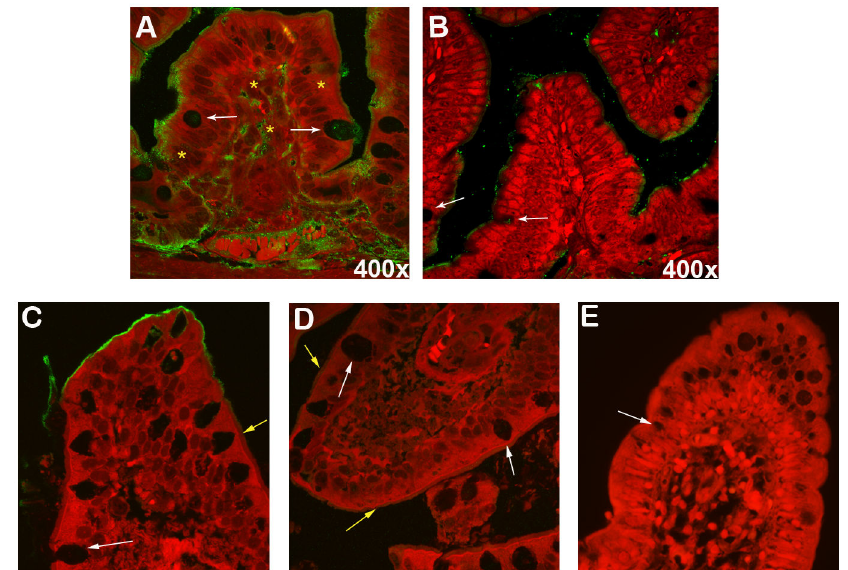
Figure 6. Ricin binds to villi in the small intestine. IF of small intestines from mice 24 hours after gavage with ricin (A) or PBS (B). Ricin was detected by IF after treatment with primary rabbit polyclonal anti-RTA and goat anti-rabbit Ig-AlexaFluor ® 488 secondary antibody. Note that the small intestines from 3/3 mice euthanized at 24 hours post gavage were positive for ricin. Magnification: 400x. Normal human small intestinal tissue [A, (400x), B, (400x)] was overlaid with ricin (C), PBS (D), or ricin pre- incubated with lactose (E). White arrows indicate goblet cells and yellow arrows indicate the brush boarder. Ricin was detected in human tissues as described above. Yellow asterisks indicate ricin within epithelial cells and the lamina propria. doi: